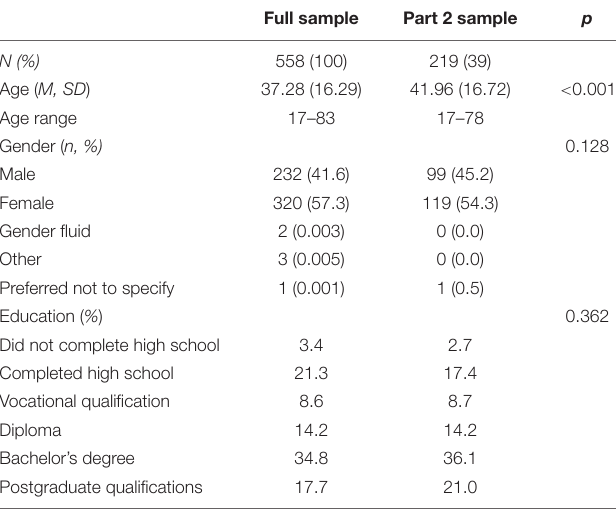
TABLE 1 | Demographic data for full sample and part 2